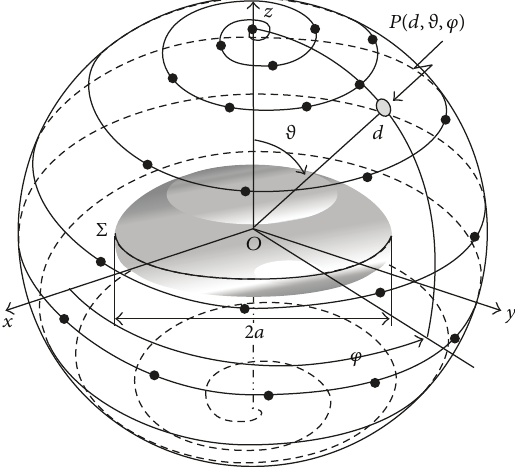
Figure 7: Spherical spiral scanning for a quasi-planar